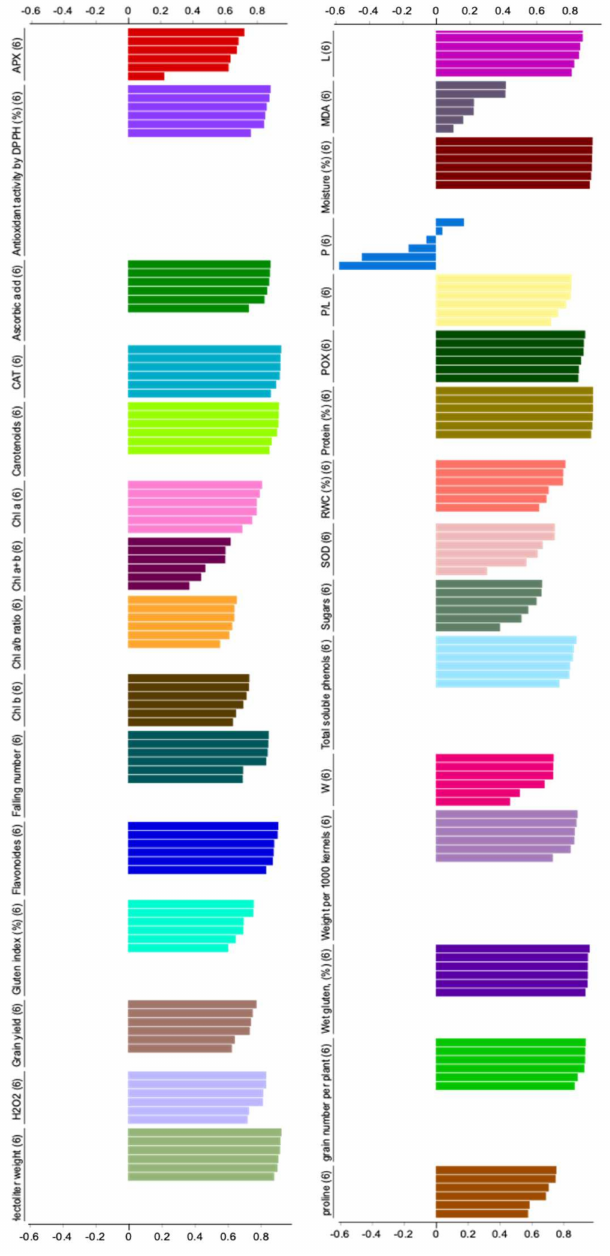
Figure 9. Plot of silhouette analysis values for clustering of all parameters based on “seed soaking and foliar application” treatments variables. On the y-axis each cluster is ordered by decreasing silhouette value. The silhouette value can range between − 1 and